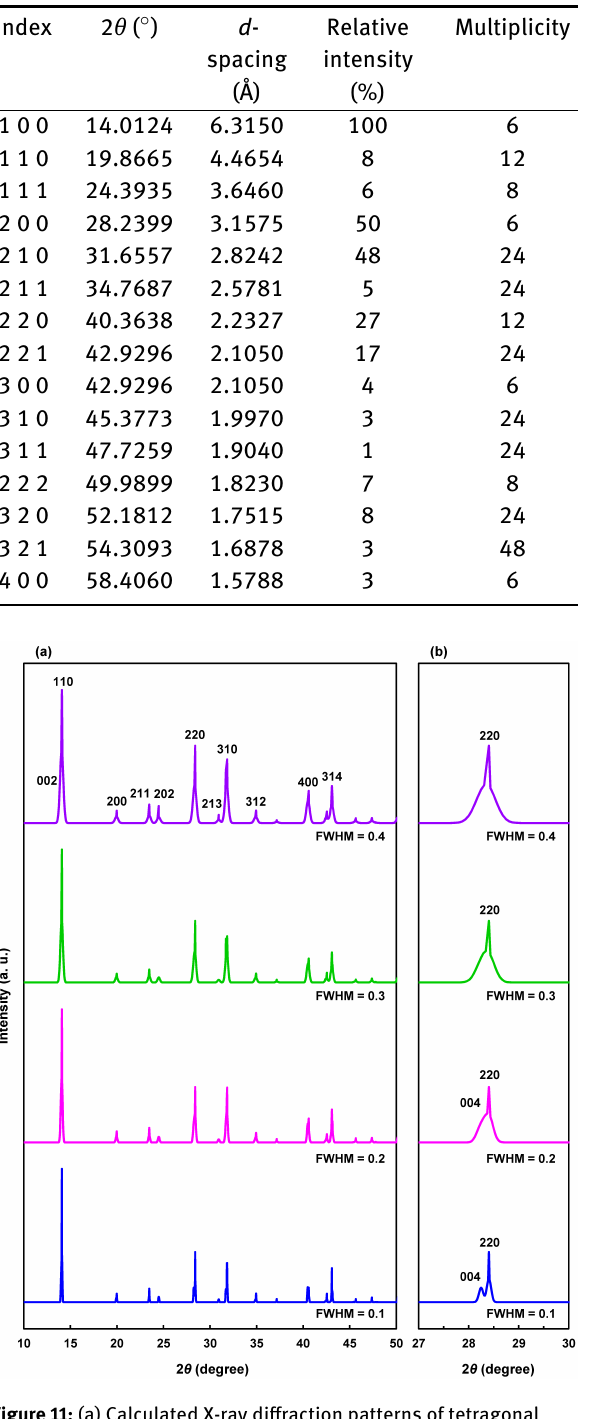
Table 7: Calculated X-ray diffraction parameters of tetragonal CH 3 NH 3 PbI 3 . Equivalent indices were combined. For space